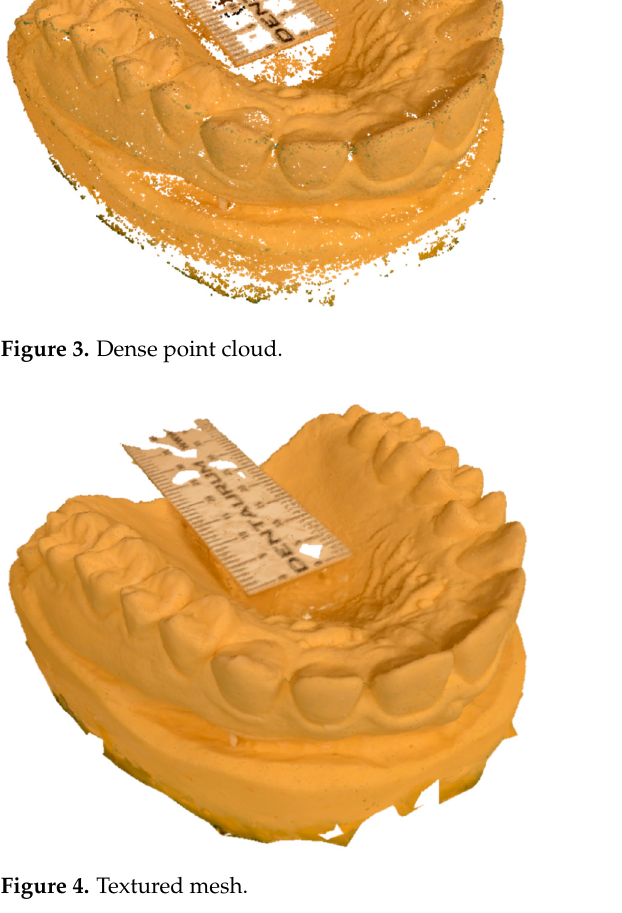
Figure 4. Textured Figure 4. Textured mesh.